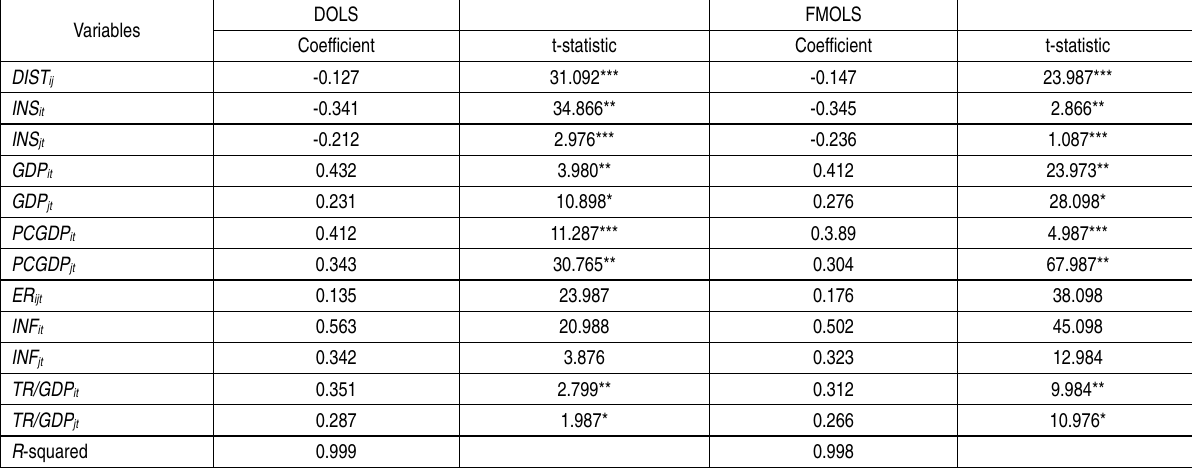
Table 3. Panel data analysis of long- run output elasticities